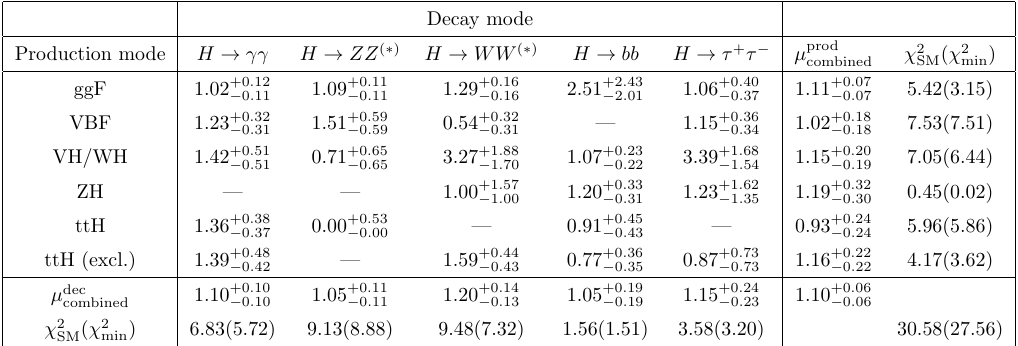
Table 3 . (LHC: 13 TeV) Combined ATLAS and CMS (13 TeV) data on signal strengths. The (cid:22) dec ( (cid:22) prod ) represents the combined signal strength for a speci(cid:12)c decay (production) combined combined channel by summing all the production (decay) modes, and (cid:31) 2 are the corresponding minimal min chi-square values. In the VH/WH row, the production mode for H ! (cid:13)(cid:13) and H ! ZZ ( (cid:3) ) is VH while it is WH for H ! WW ( (cid:3) ) and H ! (cid:28) + (cid:28) (cid:0) ; for the remaining decay mode H ! b (cid:22) b , we combine the two signal strengths from WH and VH, see table